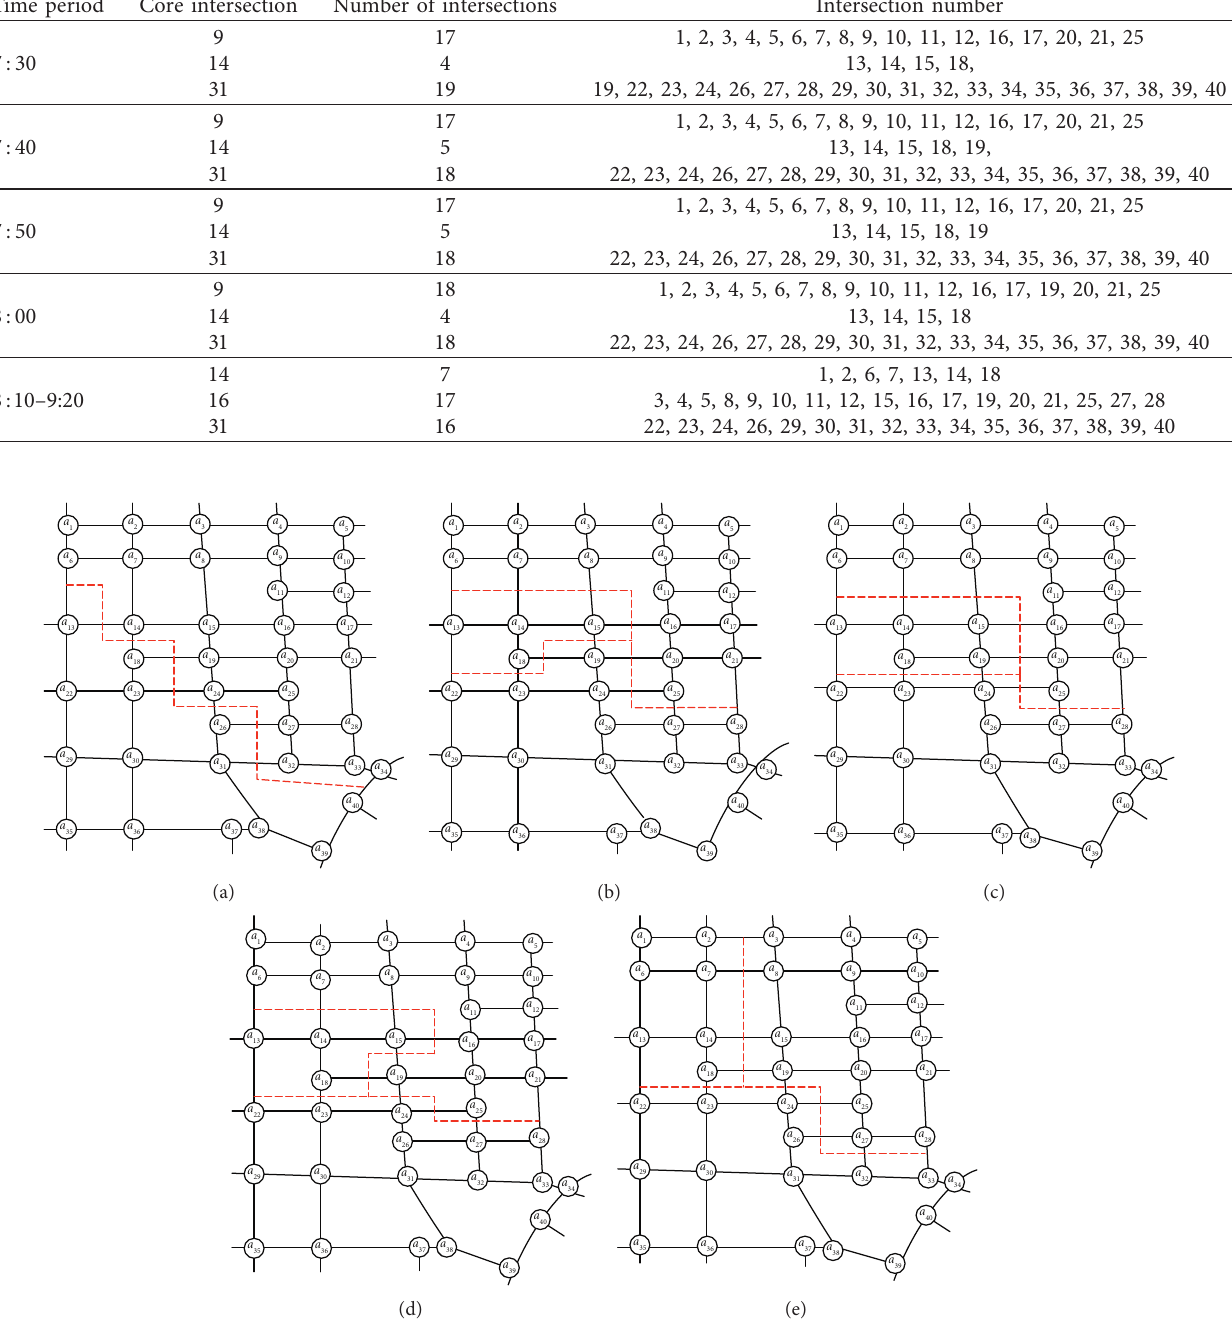
Figure 5: Traffic area subarea partition result. (a) Results of preliminary partition of subareas. (b) 7 :30 time period. (c) 7:40 and 7: 50 time periods. (d) 8:00 time period. (e) 8 :10–9: 20 time